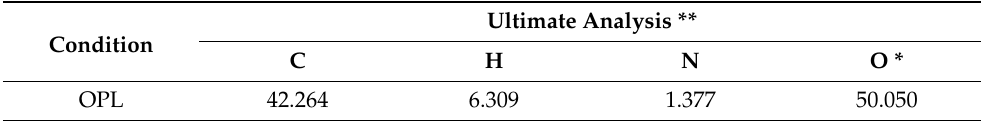
Table 1. The ultimate analysis of oil palm leave